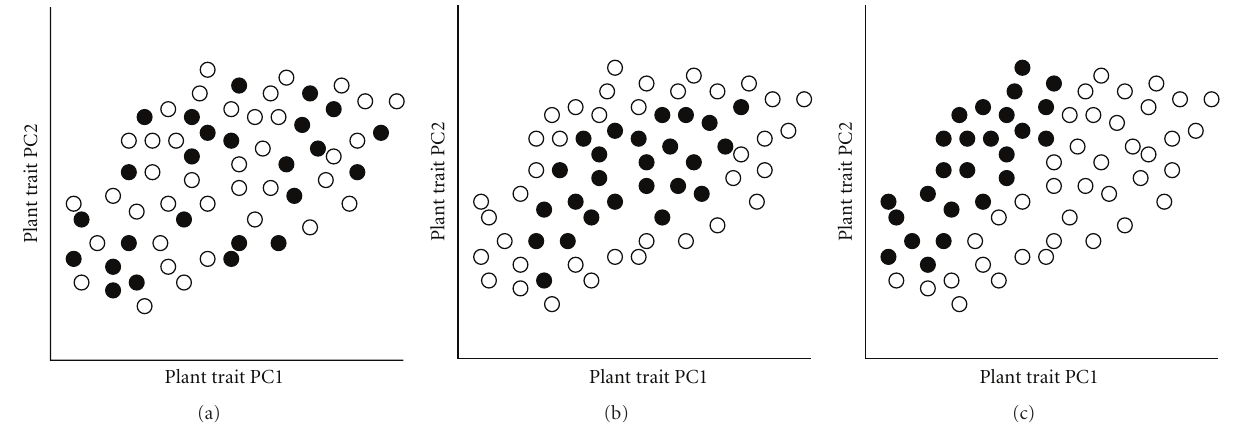
Figure 1: Possible patterns of host trait-space use by herbivorous insects. Available host-plant individuals form a cloud in trait space (which is likely multidimensional, but summarized here by the first two principal component axes). Open circles denote unattacked plants, and filled circles attacked